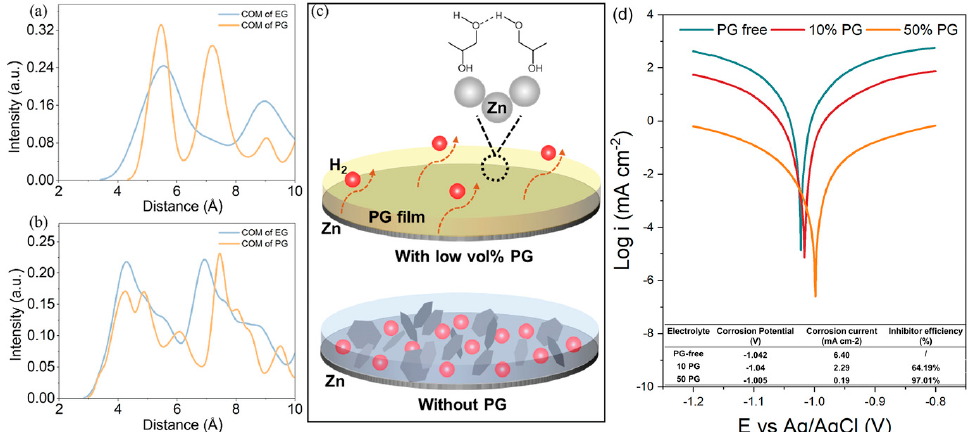
Figure 13. Ab initio molecular dynamics simulation of the concentration-dependent effectivity of PG. Distributions for the PG/EG center of mass (denoted as COM) distance at ( a ) low and ( b ) high concentrations. The appearance of well-defined sharper peaks for PG at the low concentration indicates self-organization mediated film formation (as depicted in ( c )) that owing to hydrophobic nature ( − CH 3 tail and hydrocarbon backbone) can remove the hydrogen bubbles from the zinc surface that in the PG free electrolyte induces porous and flaky zinc deposit formation. ( d ) Tafel plots obtained for the PG-free, 10% PG, and 50% PG electrolytes with the corresponding corrosion potential, corrosion current density, and inhibitor efficiency listed in inset table. Reproduced with permissions from Ref. [98]. Copyright © 2022 WILEY-VCH.